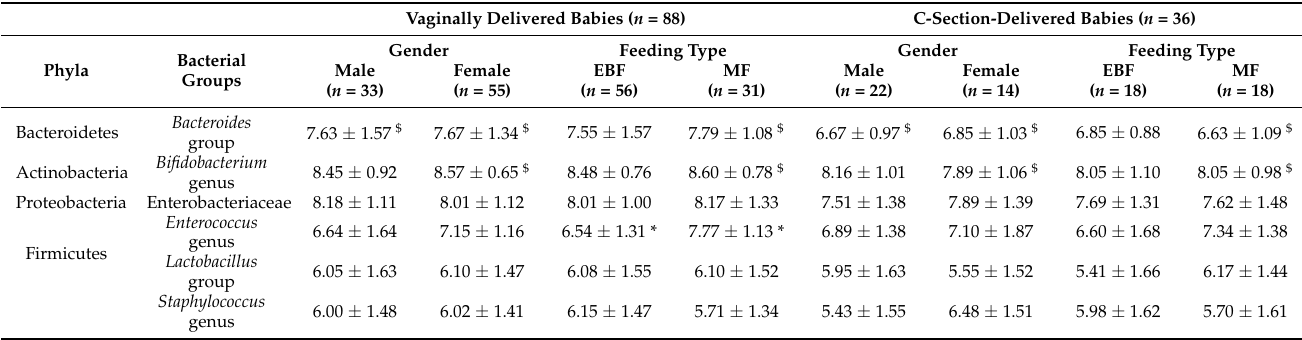
Table 2. Levels (Log nº cells/g) of some relevant bacterial groups in fecal samples of the vaginally delivered or C-section- delivered infant population included in this study, categorized by feeding type, gender and mode of delivery.